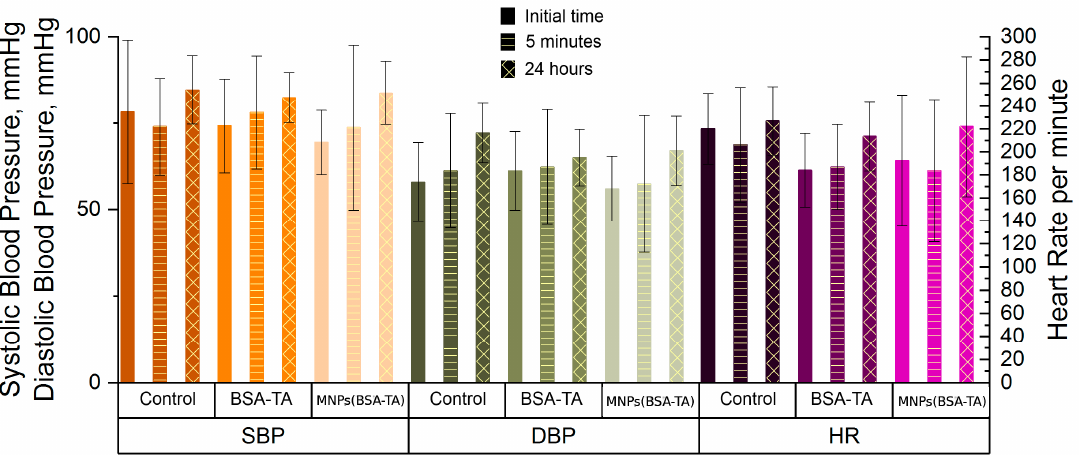
Figure 11. Effect of microcarriers on cardiovascular system. SBP – systolic blood pressure, DBP – diastolic blood pressure, HR – heart rate. An increase in SBP and DBP in the group receiving MNPs (BSA-TA) carriers and DBP in the control group was observed. Discussion in the text.